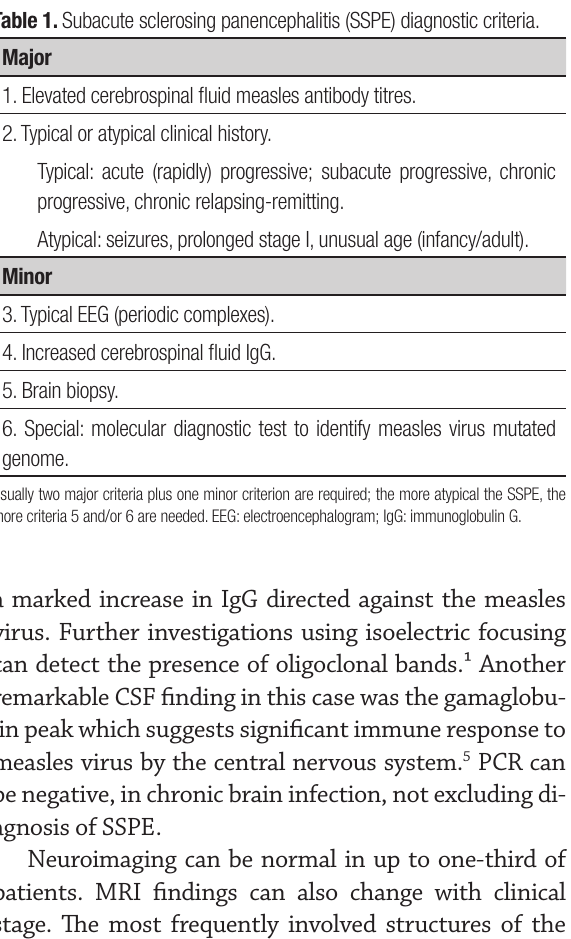
Figure 3. Immunohistochemistry for detection of measles antibodies in the central nervous system.